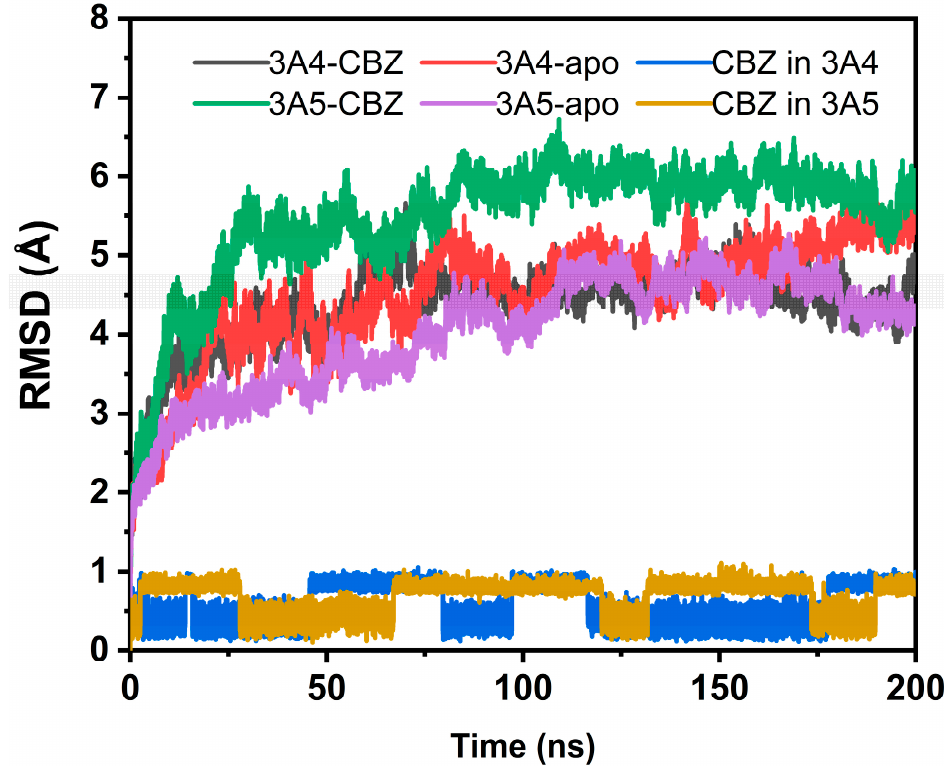
Figure 2. Time dependence of RMSD values in the four systems, along with the substrate